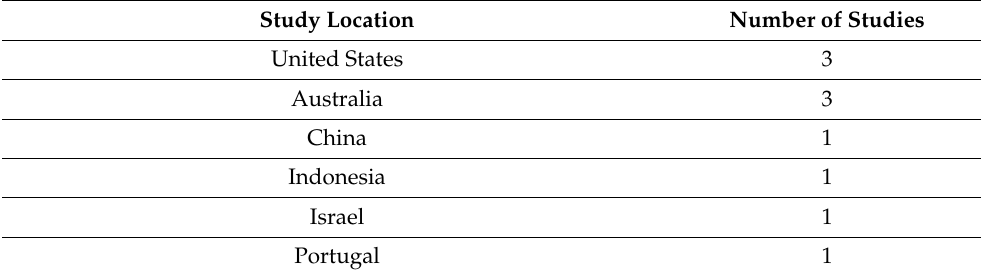
Table 2. Summary of locations (countries) of the studies included in this systematic